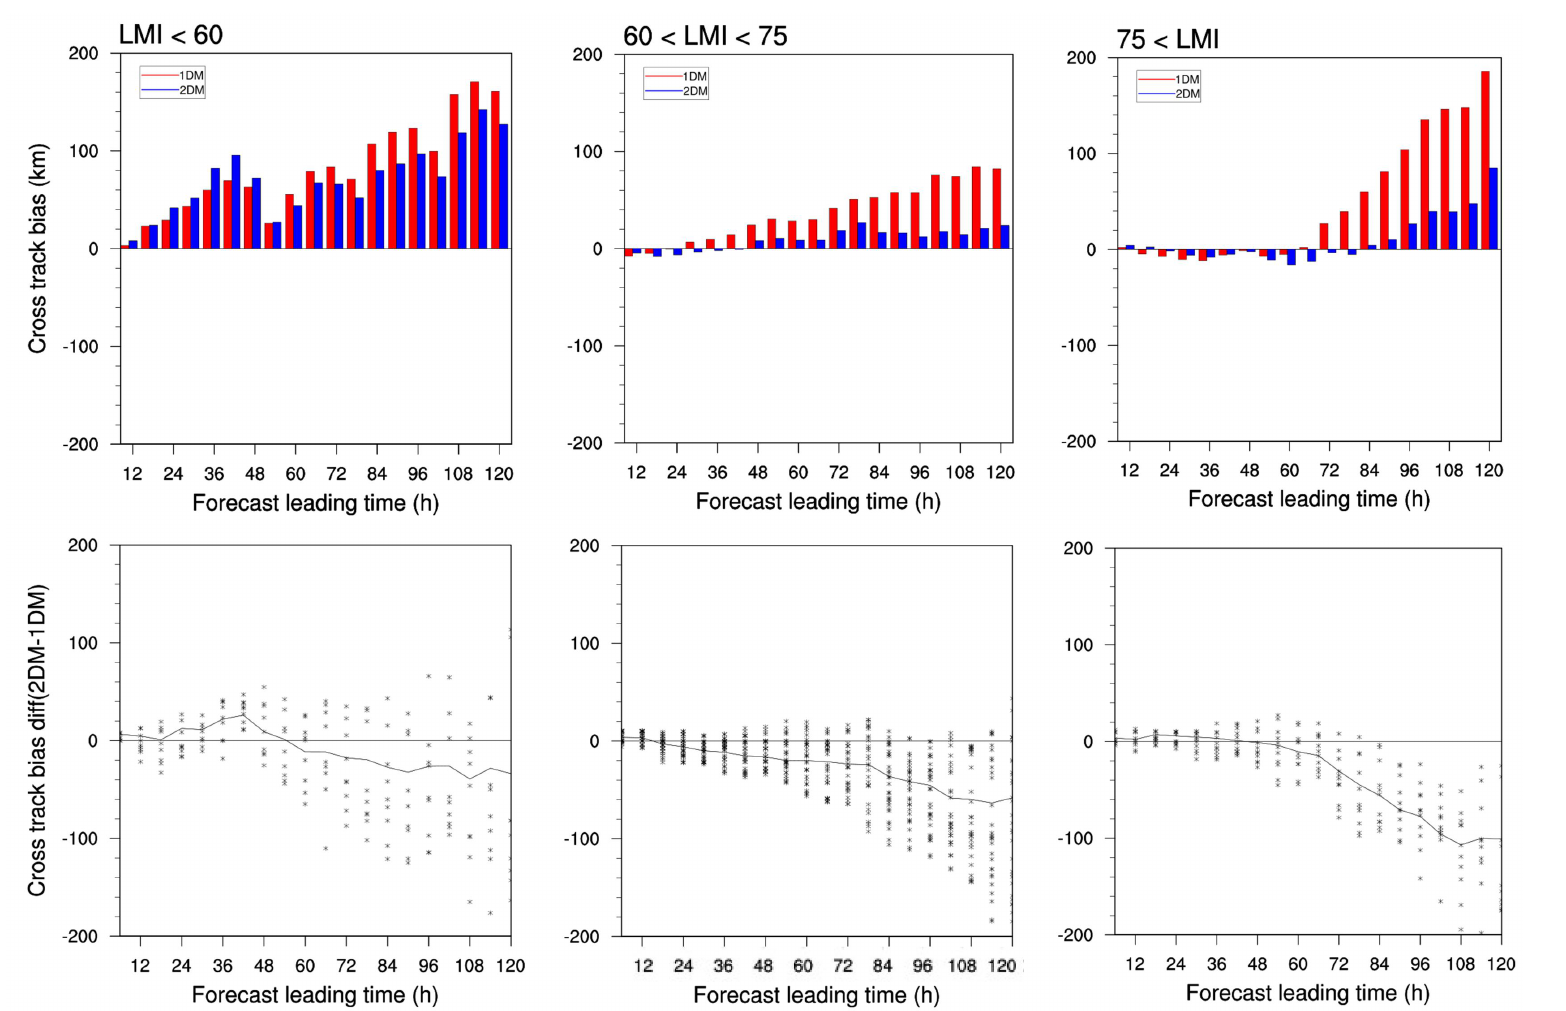
Figure 5. Mean cross-track biases (top) and scatter plots of differences between two experiments (bottom) for TCs with three intensity categories (LMI < 60 m s − 1 , 60 m s − 1 < LMI < 75 m s − 1 , and 75 m s − 1 <